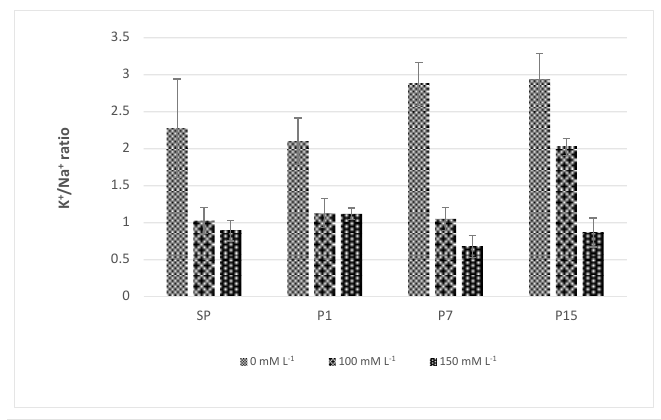
Fig. 4 The effect of salinity and bacterial inoculation with Pseudomonas strains (P1, P7, and P15) on the K + /Na + ratio of Vicia faba plants. The SP treatment was not